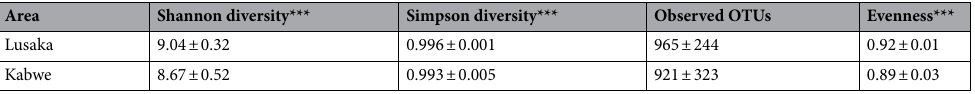
Table 1. Alpha diversity indices averaged across the fertilizer treatments and sampling dates (mean ± SD). Levels of significance (*, **, and *** represent p < 0.05, < 0.01, and < 0.001, respectively) were based on a Student’s